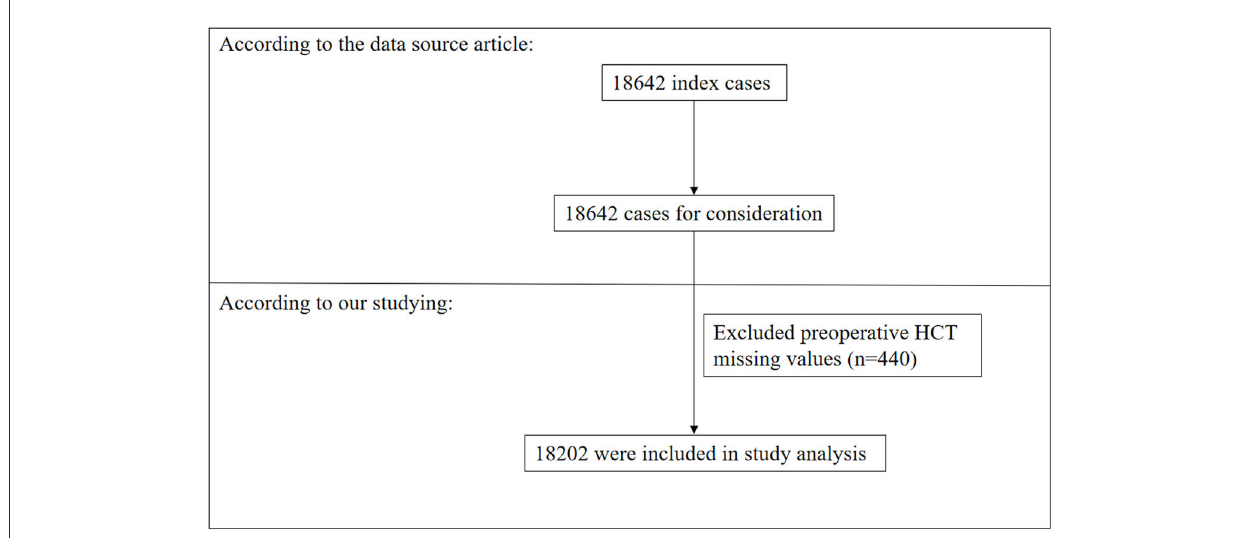
FIGURE1 Flowchart of the study participants.